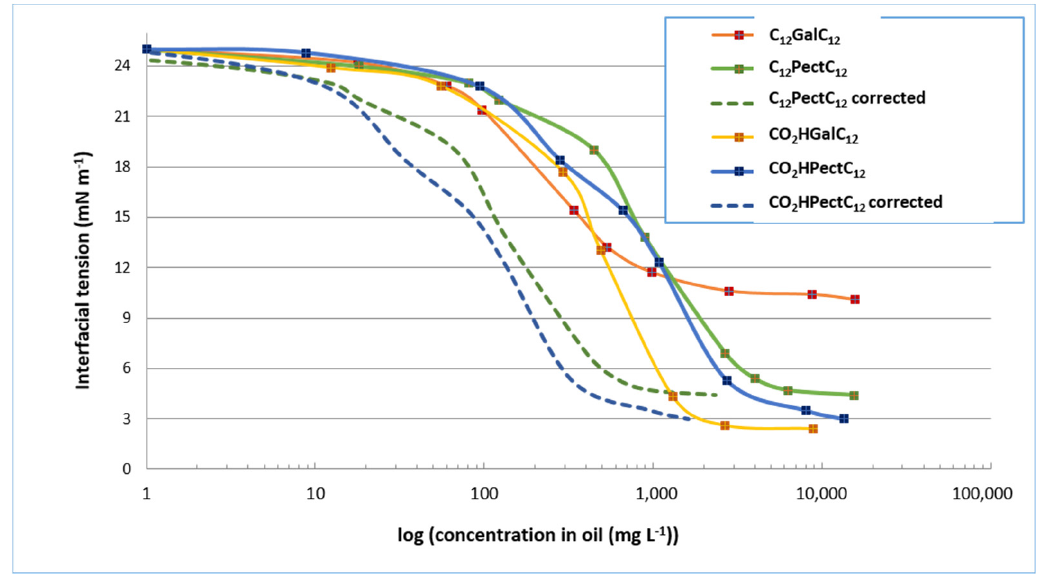
Figure 8. Values of the interfacial tension of surfactant compositions derived from lauric alcohol.